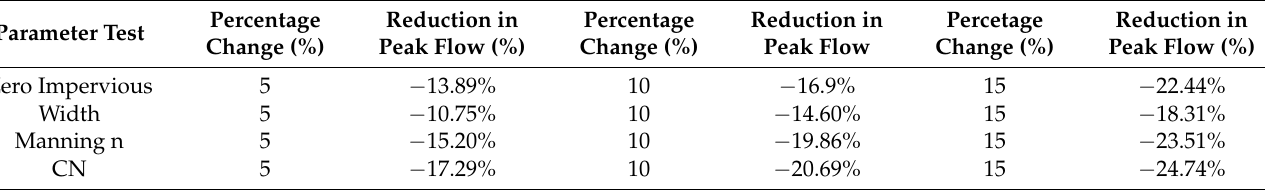
Figure 8. IDF curves for the historical ( a ) and future ( b ) periods for the selected station (3u). Table 4. Sensitivity analysis of SWMM parameters on peak